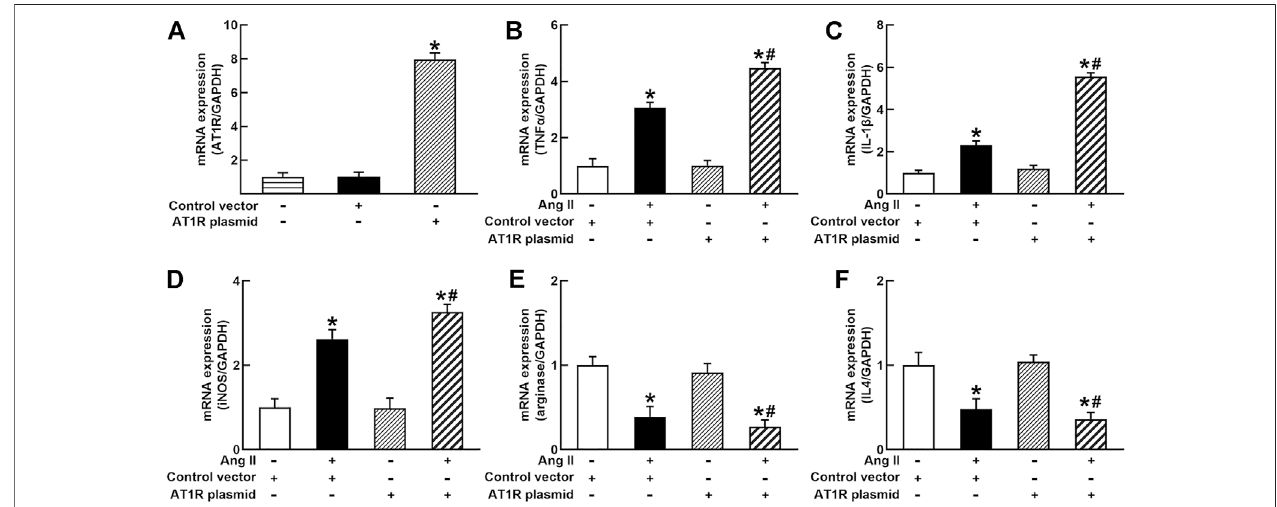
FIGURE 1 | Effects of angiotensin type 1 receptor (AT1R) overexpression on mRNA expressions of M1 and M2 macrophage cytokines in THP-1/macrophages. The transfection of the AT1R gene increased AT1R expression (A) ; AT1R overexpression potentiated Ang II-induced mRNA expression of M1 macrophage cytokines such as tumor necrosis factor (TNF α ) (B) , interleukin 1 β (IL-1 β ) (C) , and inducible nitric oxide synthase (iNOS) (D) ; overexpression of AT1R further decreased Ang II- induced mRNA expression of M2 macrophage cytokine genes arginase (E) and IL4 (F) . Statistical comparisons were carried out with one-way ANOVA (A) or two- way ANOVA (B – F) followed by the Tukey post hoc test. Data were expressed as mean ± SEM. N = 6, * p < 0.05 vs. control vector, # p < 0.05 vs. Ang II group.